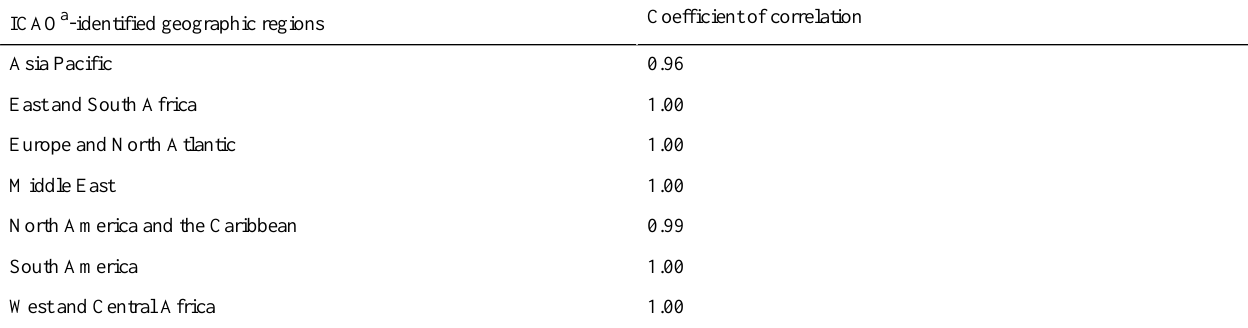
Table 1. Correlation between the number of daily international flights officially reported by the International Civil Aviation Organization and those obtained from the Collaborative Arrangement for the Prevention and Management of Public Health Events in Civil Aviation dashboard for 7 geographic regions from April to October 2020.